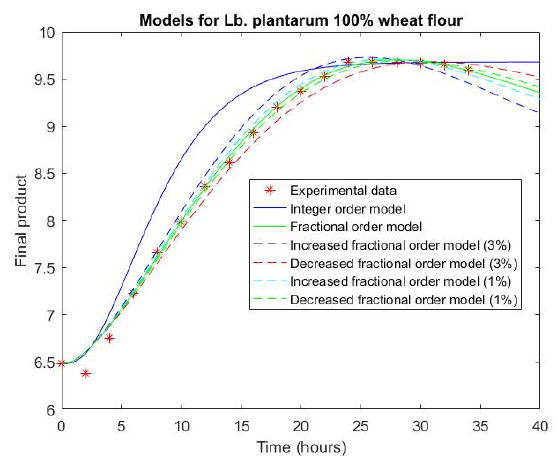
Figure 1. Comparison between simulated and experimental data for experiment 1 using Lactobacillus plantarum .